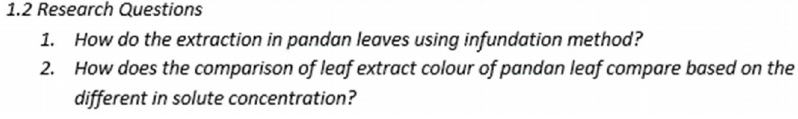
Figure 2. examples of student answers who got a score of 5 in writing the